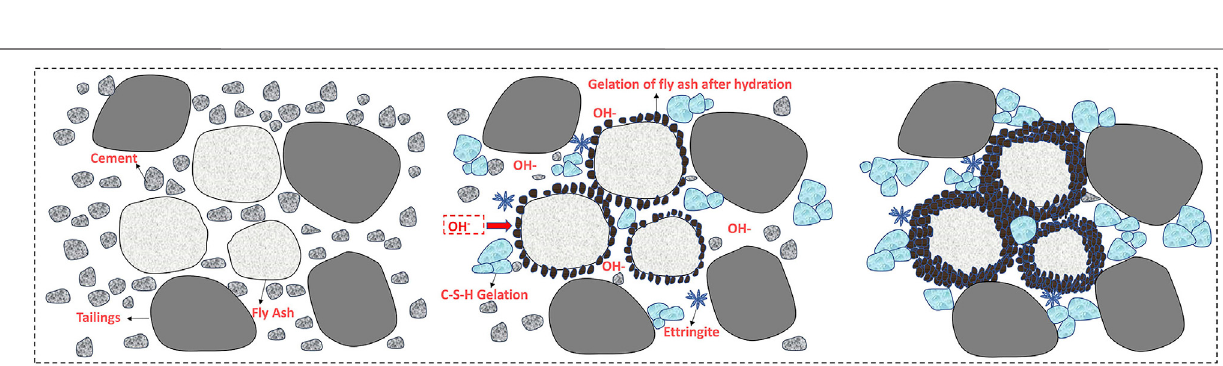
FIGURE 12 | Scanning electron microscope comparison of the back fi ll. (A) 28 d back fi ll of stope. (B) 28 d back fi ll of group A3. (C) 28 d back fi ll of group B3. (D) 56 d back fi ll of group A3.